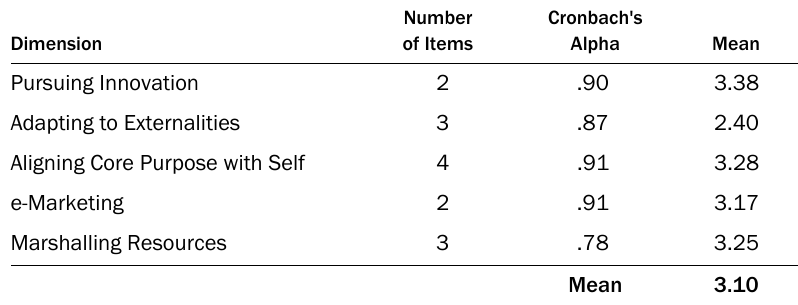
Table 2. Descriptive Statistics and Reliability for Mentors’ TeMMentSE